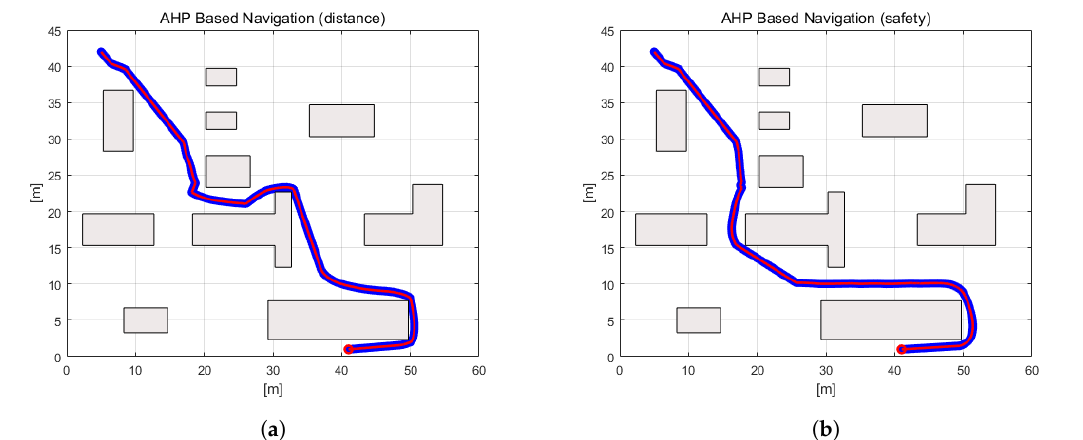
Figure 9. Safety margin under obstacles: ( a ) AHP based path planning with short distance preference ( b ) AHP based path planning with high safety